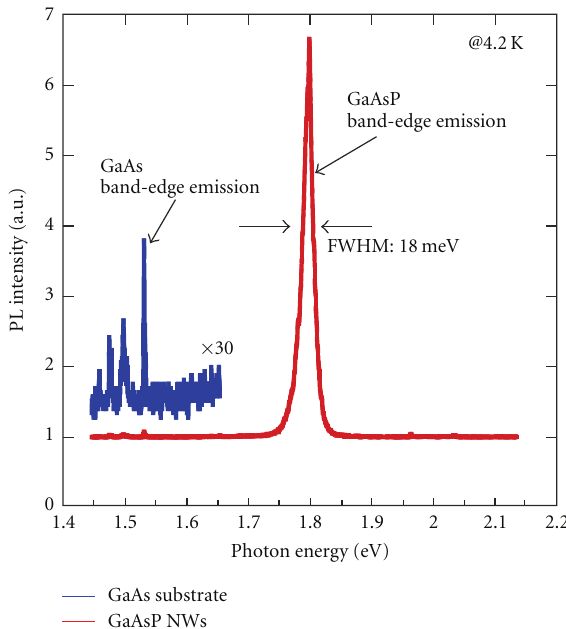
Figure 13: PL spectra for GaAsP NWs and GaAs substrate at 4.2K